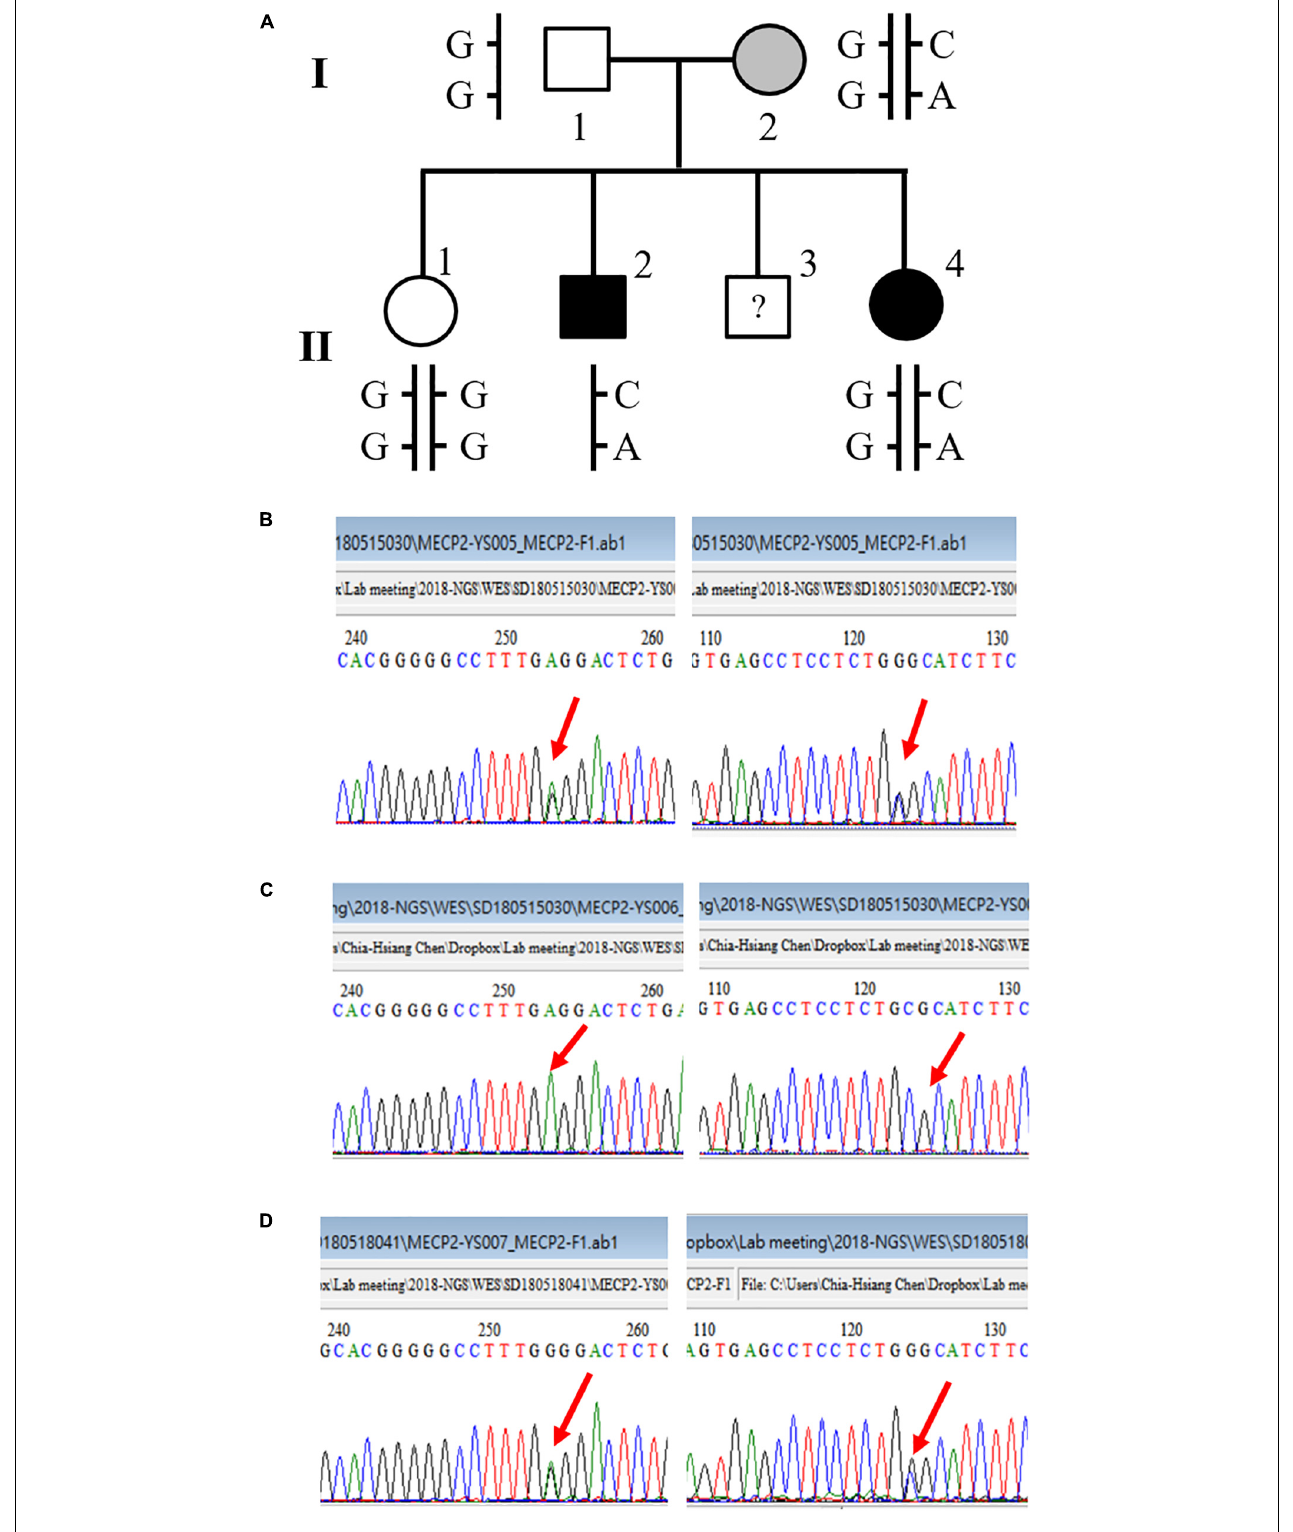
FIGURE 2 | A novel double-missense mutation was identified in a multiplex family. (A) Pedigree of the family with two affected siblings. (B) Sequencing results of P376S and P419R double mutation of the mother (I-2). (C) Sequencing results of P376S and P419R double mutation of the son affected with chronic schizophrenia (II-2). (D) Sequencing results of P376S and P419R double mutation of the affected daughter (II-4).